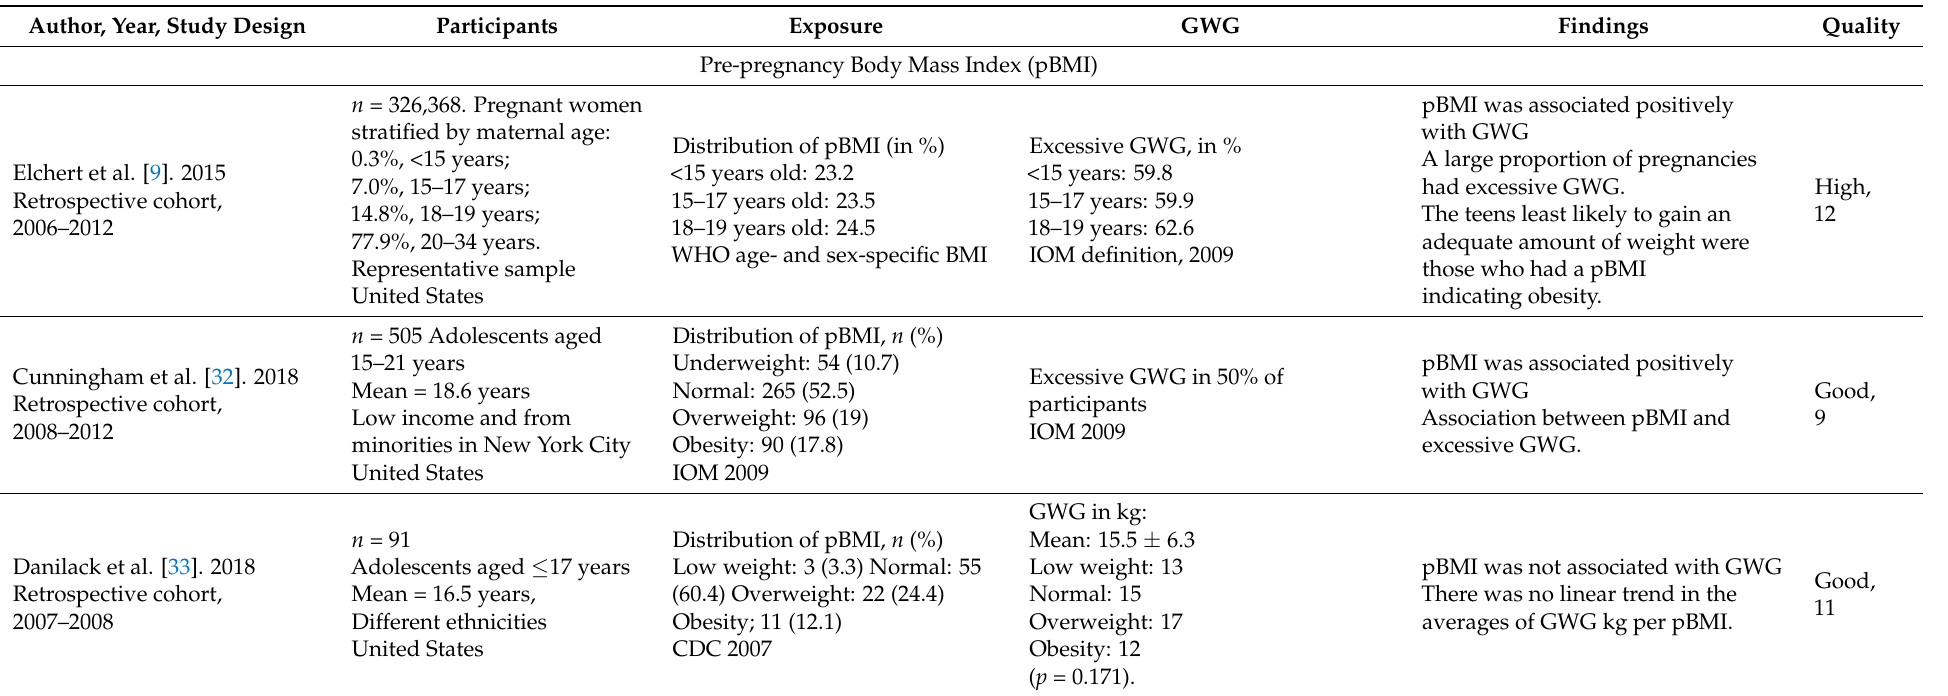
Table 1. Synthesis of studies on individual characteristics and gestational weight gain in pregnant